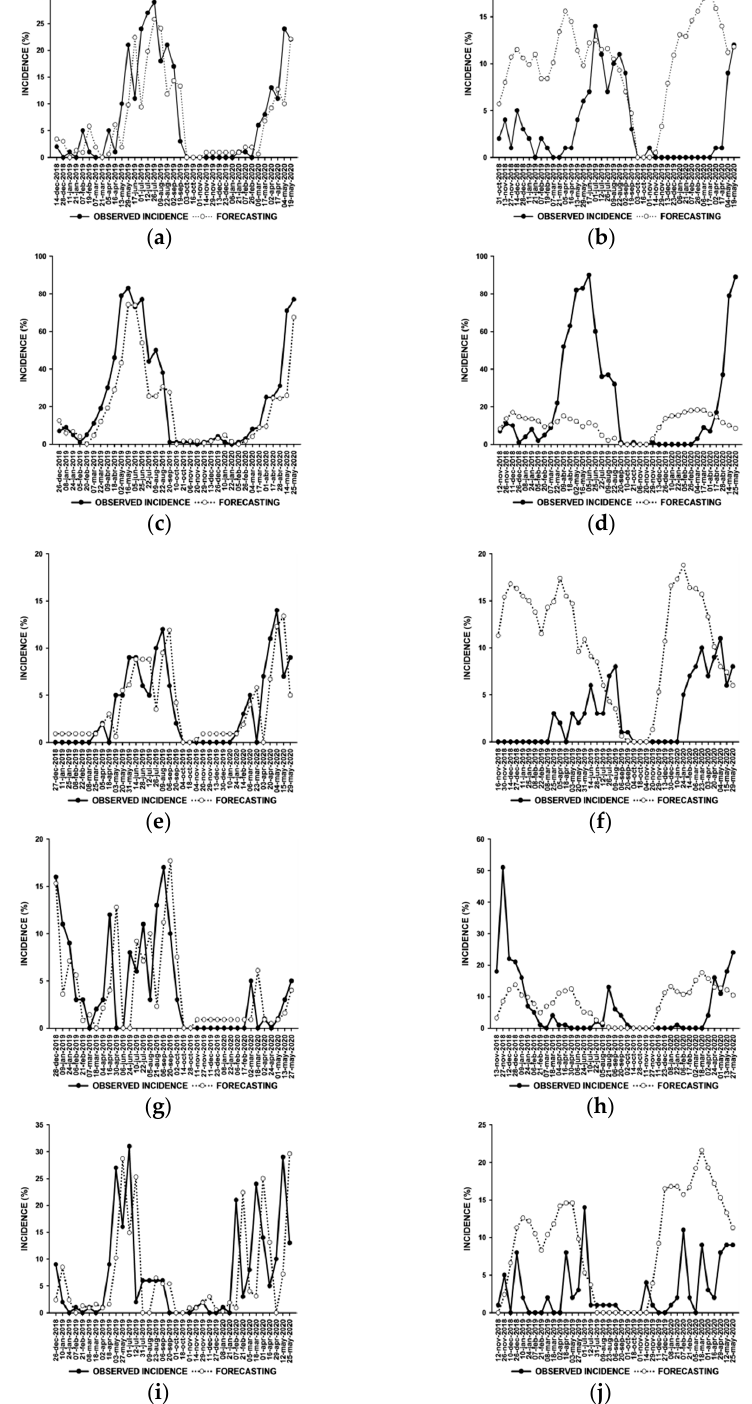
Figure 3. Comparison of the 5% control level methodology (DSS 1) and the Model developed by Pinto et al. [18] (DSS 2) to forecast coffee rust for the five municipalities in the Minas Gerais state, Brazil: ( a ) and ( b ) DSS 1 and DSS 2 applied in Carmo do Rio Claro, respectively; ( c ) and ( d ) DSS 1 and DSS 2 applied in Monte Santo de Minas, respectively; ( e ) and ( f ) DSS 1 and DSS 2 applied in Nova Resende, respectively; ( g ) and ( h ) DSS 1 and DSS 2 applied in Rio Paranaíba, respectively; ( i ) and ( j ) DSS 1 and DSS 2 applied in Serra do Salitre, respectively.